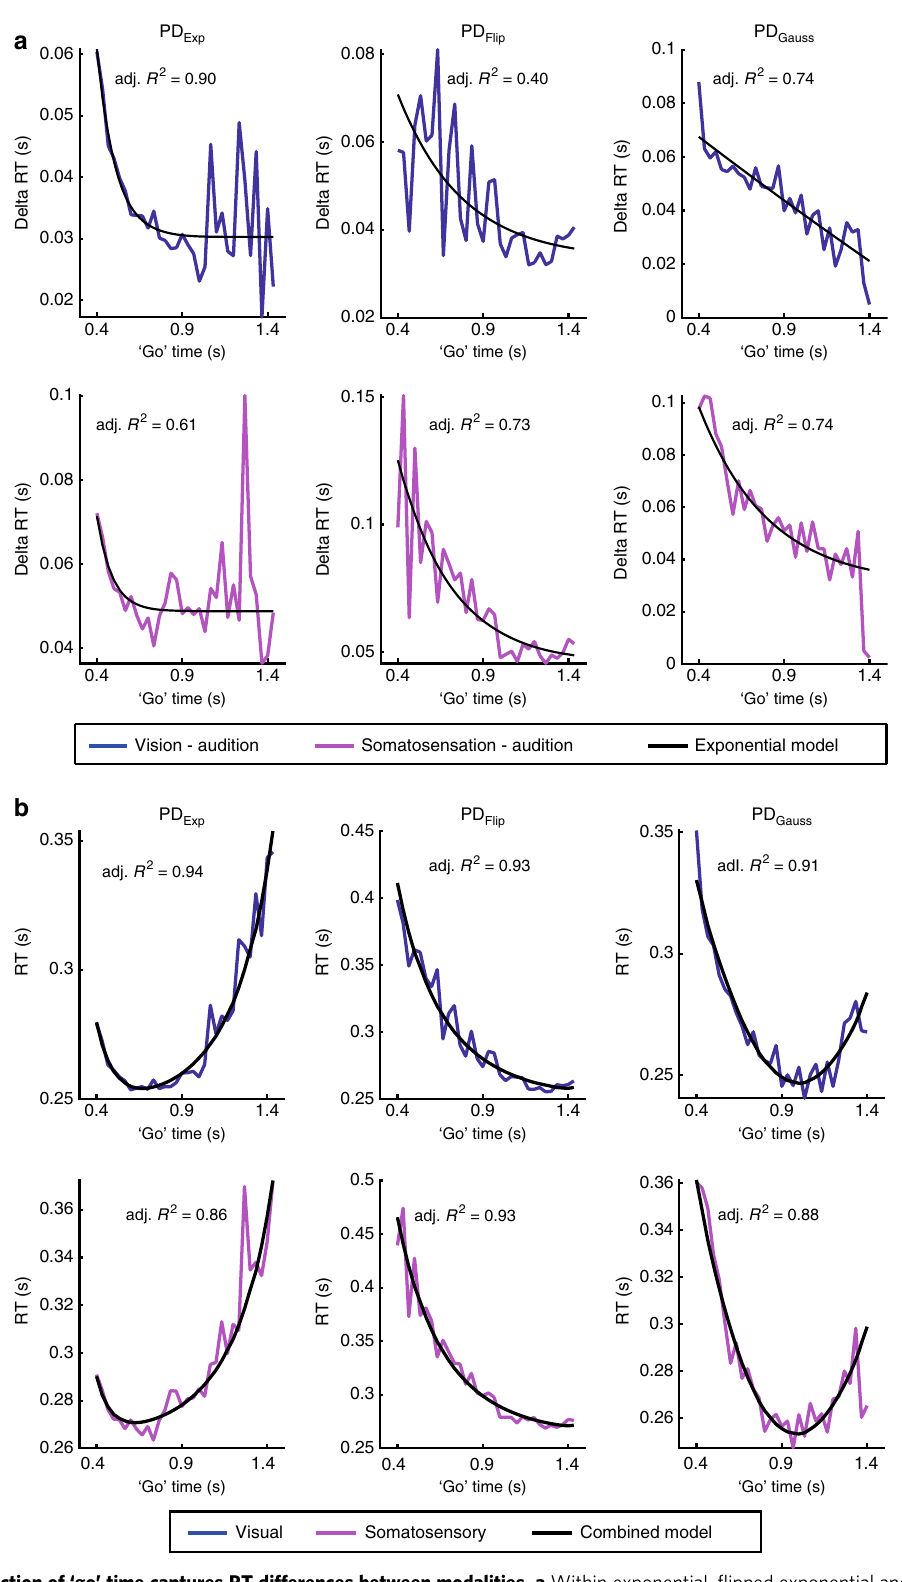
Fig. 5 Exponential function of ‘ go ’ time captures RT differences between modalities. a Within exponential, fl ipped exponential and Gaussian conditions, Δ RT curves were calculated by subtracting auditory RT curves from visual (blue) and somatosensory (magenta) ones. The Δ RT curves show a decrease over the range of ‘ go ’ times, most pronounced at shorter ‘ go ’ times, for all distributions. An exponential model (black curves) of ‘ go ’ time (Eq. (19)) captured the Δ RT curves ’ behavior. b The fi tted exponential model was added to the reciprocal, probabilistically-blurred PDF model fi tted to auditory RT and plotted against visual and somatosensory RT. This combined model captured the previous deviations between data and model at shorter ‘ go ’ times in all conditions in both vision and